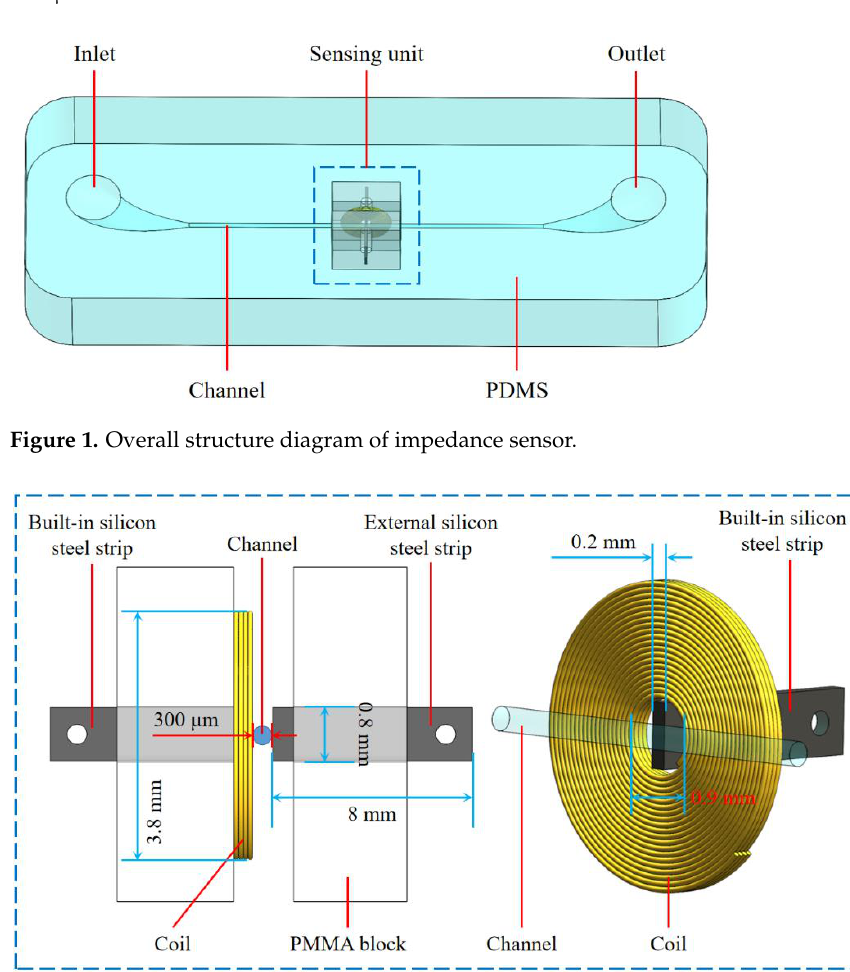
Figure 2. Structure of sensing unit.